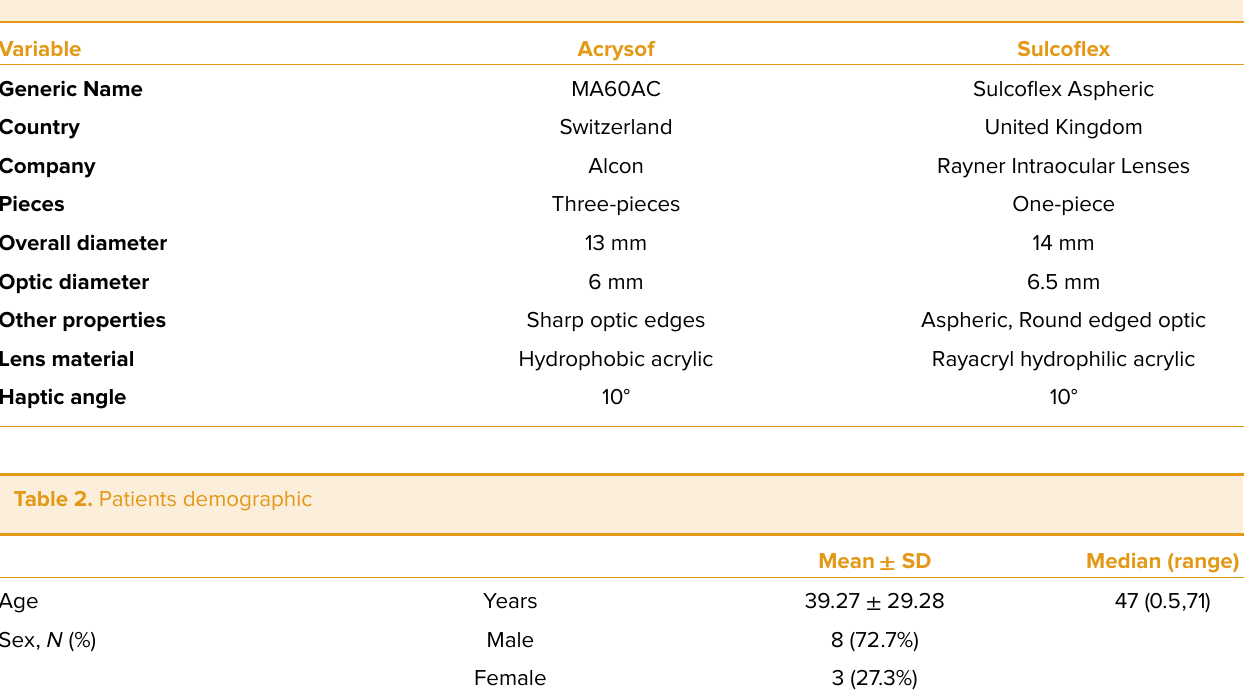
Table 1. Comparison of two types of intraocular lenses